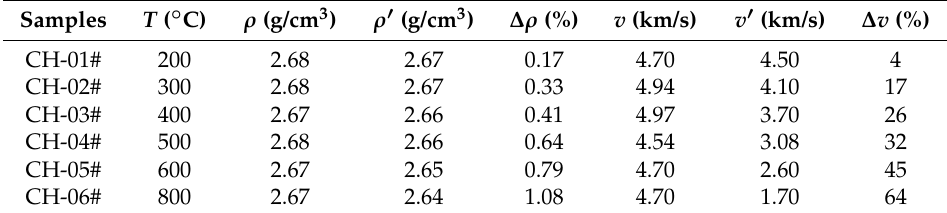
Table 1. Physical properties of granite